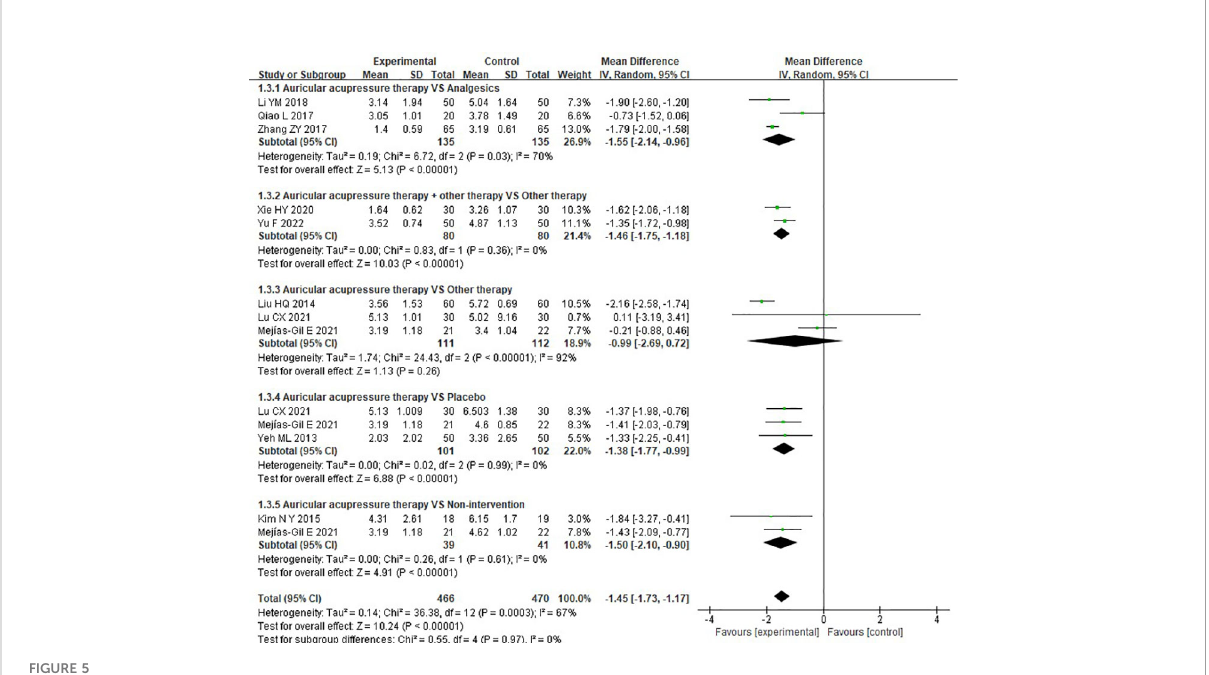
FIGURE 5 Meta-analysis and forest plot for VAS score.